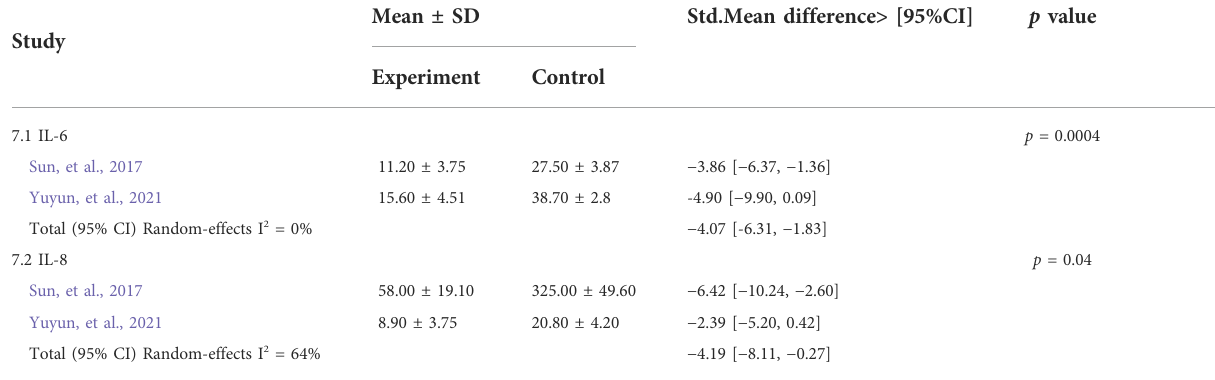
TABLE 7 Analysis of in fl ammatory cytokines in preclinical studies in